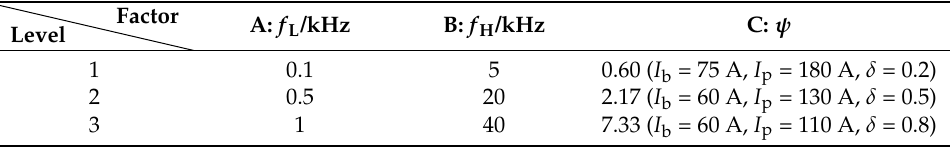
Table 1. Levels of welding process parameters.